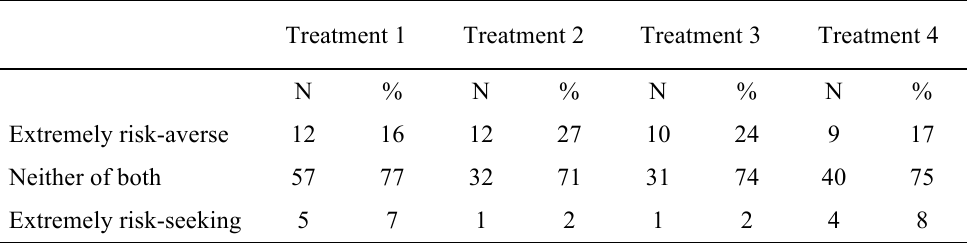
Table A4.2. Results of the risk